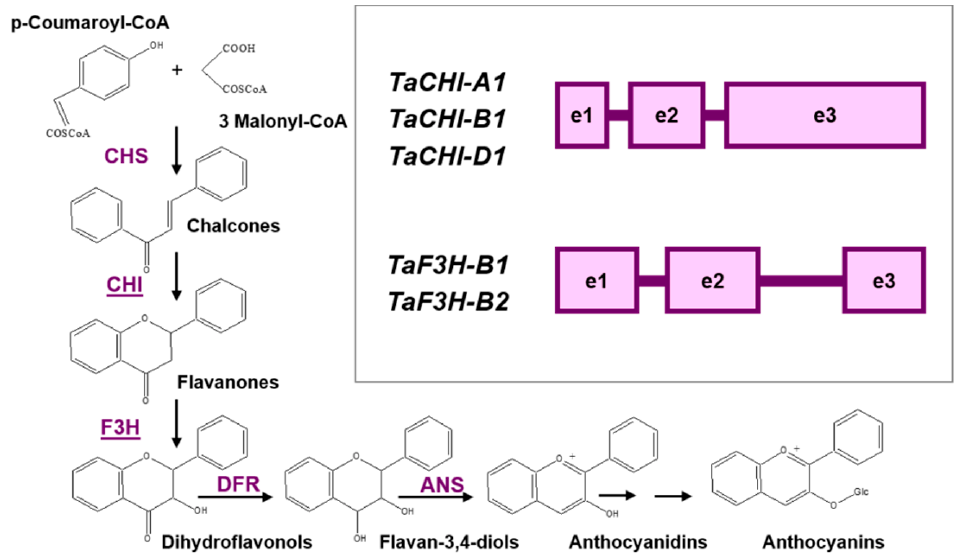
Figure 1. Scheme of the anthocyanin biosynthesis pathway. The rectangle shows the exon-intron structure of the TaCHI-A1 , TaCHI-B1 and TaCHI-D1, plus TaF3H-B1 and TaF3H-B2 genes of bread wheat ( T. aestivum ). Enzymes: ANS—anthocyanidin synthase; CHI—chalcone-flavanone isomerase; CHS—chalcone synthase; DFR—dihydroflavonol 4-reductase; F3H—flavanone 3-hydroxylase.